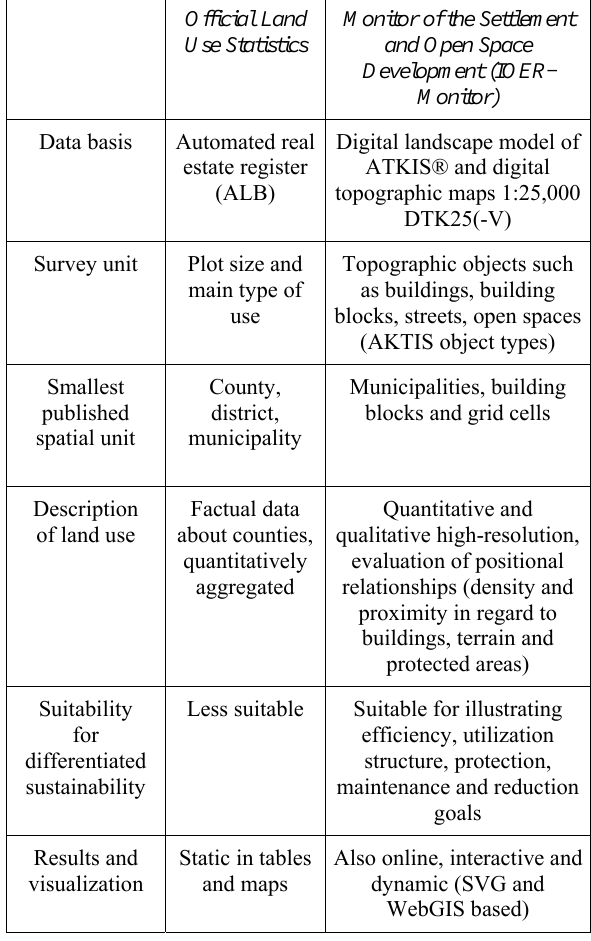
Table 1. Comparison of the Official land use statistics and the Monitor of settlement and open space development (IOER-Monitor)